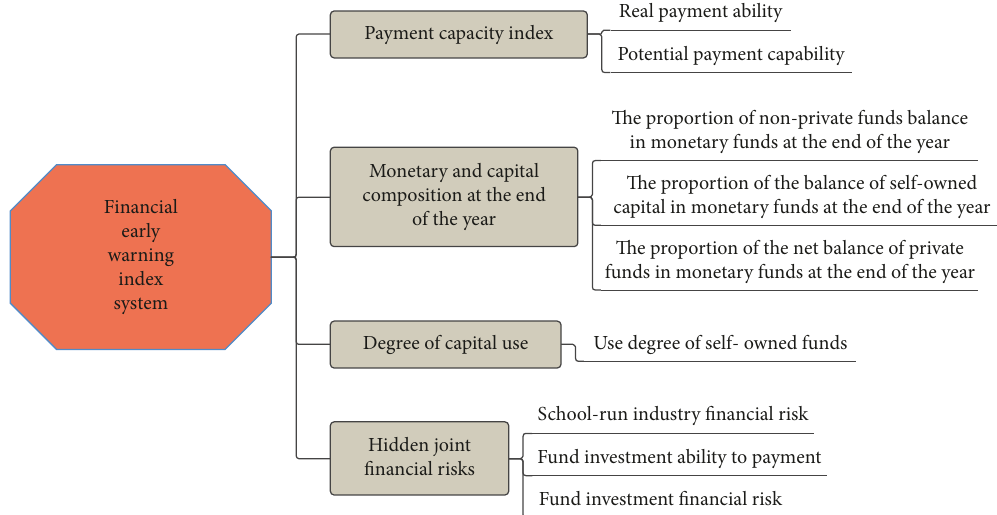
Figure 6: The establishment of the financial risk early warning indicator system in colleges and universities.